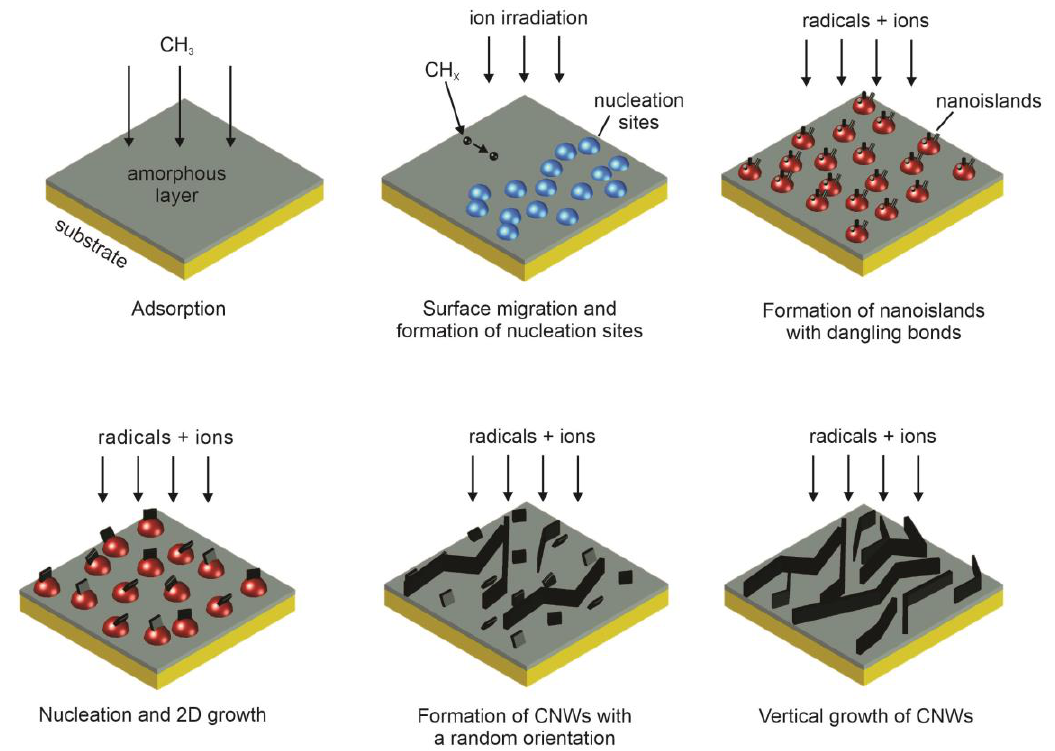
Figure 3. Schematic presentation of CNWs growth mechanism as suggested by Hiramatsu [9].